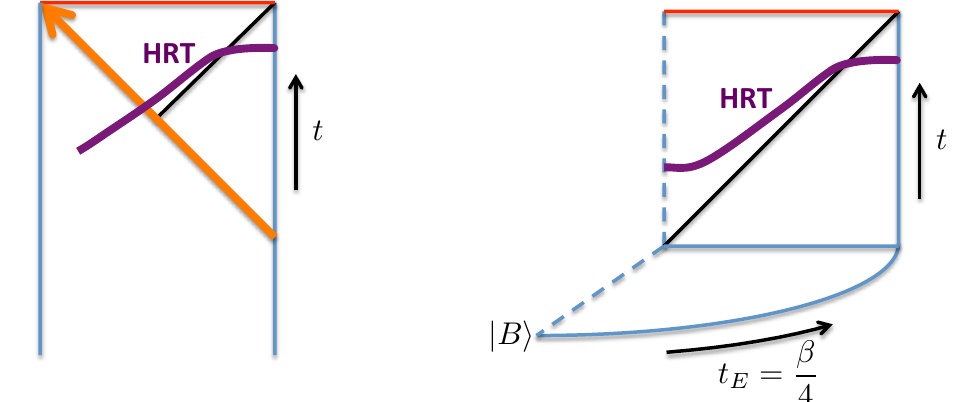
Figure 2. Left: Vaidya quench model. The infalling null shell is drawn by an orange arrow. Below the shell the geometry is pure AdS, above the shell it is a static black brane. We get time evolution of the entropy in the boundary theory because the HRT surface lives in both parts of the geometry and passes through the null shell. Right: the boundary state model of a quench is dual to an end of the world brane cutting the eternal black hole in half. The lower portion of the (cid:12)gure illustrates how the Euclidean path integral prepares a short-range entangled initial state from the boundary state [18]. The time evolution of the entropy comes from the HRT surface entering the black brane horizon and ending on the